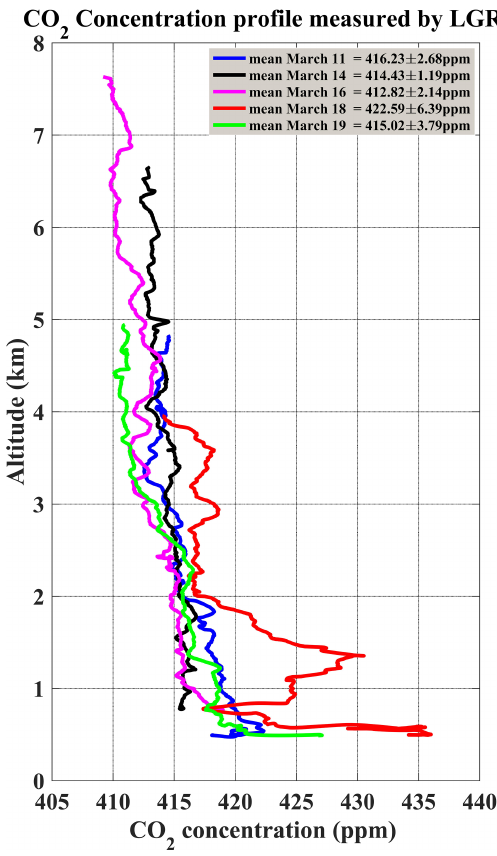
Figure 15. CO 2 concentration profile results measured by the greenhouse gas analyser during aircraft descending flight on differ- ent dates. The blue solid line is the result on 11 March. The black solid line is the result for 14 March. The purple solid line is the re- sult for 16 March. The solid red line is the result for 18 March. The green solid line is the result of 19